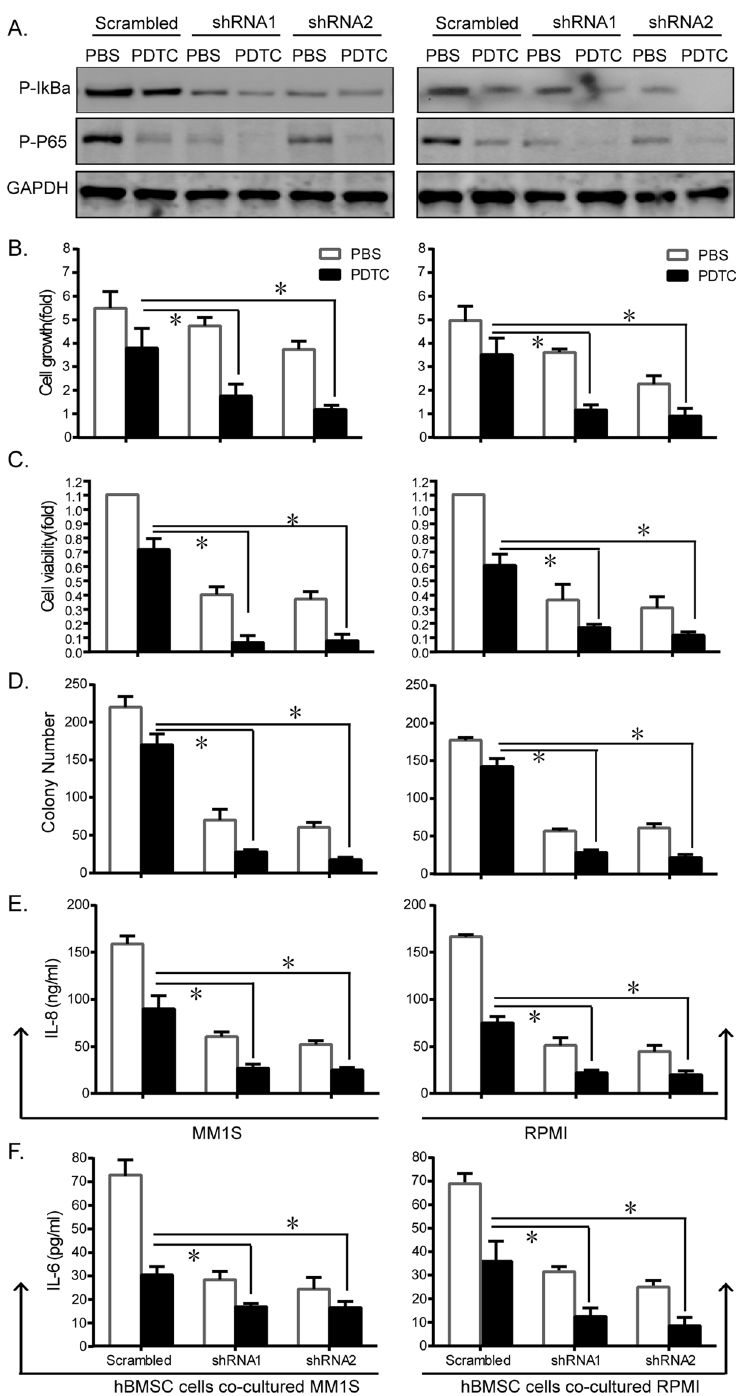
Figure 4. Inactivation of NF- κ B participated in H19-regulated cell growth. Sh-H19 transfected MM cells were treated with NF- κ B inhibitor PDTC (50 μ M for 24 h) compared with treatment with PBS as negative control. ( A ) Western blot was performed to determine phosphorylation changes of I κ B α and P65. Cell proliferation ( B ), viability ( C ), and ( D ) colony formation decreased significantly upon PDTC stimulation. The synergistic inhibitory effects were induced in terms of IL-8 secretion by MM cells ( E ) and IL-6 secretion by hBMSC cells ( F ). ( * P < 0.01, Figure is representative of 3 experiments with similar